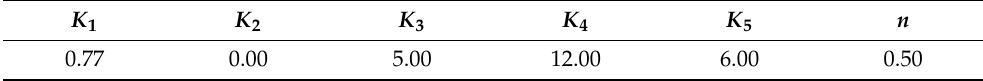
Table 2. Calculated overall rate constants K 1 – K 5 and molar ratio n for α E2 (concentration 200 µ g/L). K 1